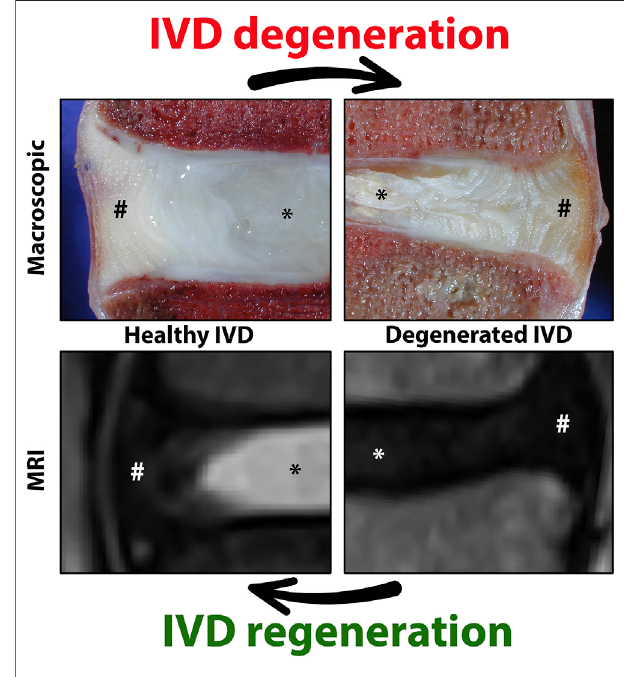
FIGURE 1 | Representation of the healthy and degenerated human intervertebral disc (IVD) at macroscopic and magnetic resonance imaging typically used to visualize the IVD. Human healthy and degenerated L4-L5 IVDs are employed, a location commonly affected in chronic low back pain. The core of the IVD [nucleus pulposus, NP (*)] is constrained by the two endplatesandtheannulus fi brosus[AF(#)].AhealthyIVDhasagel-likeNPwith high water and glycosaminoglycan content (white on the T2 weighted sequence). IVD degeneration starts with loss of glycosaminoglycan and water within the NP (black on T2w sequence). Images by courtesy of Prof. Joachim